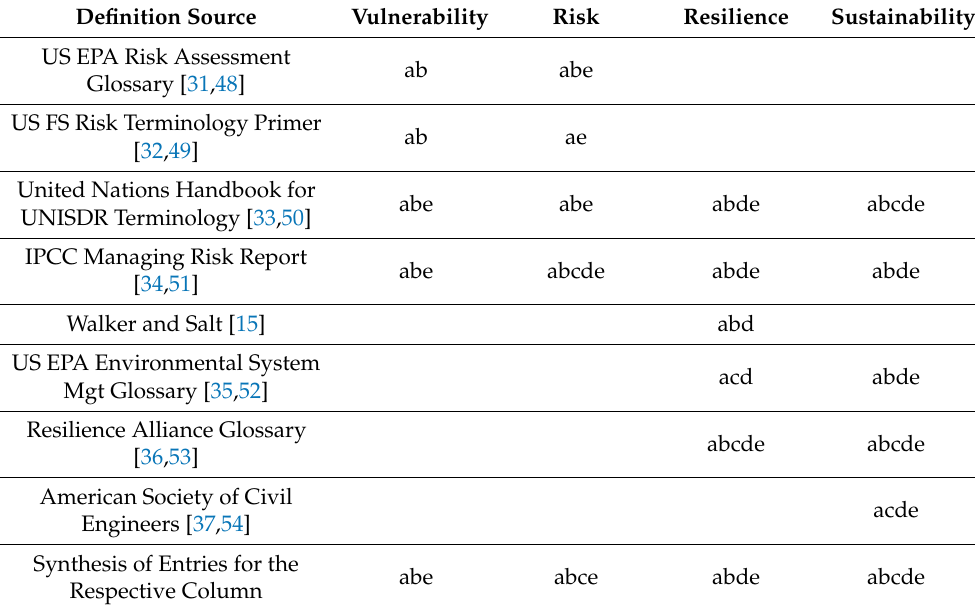
1 Table entry codes: a: system elements (e.g., stressor or receptor), each element characterized in terms of some level of functional performance. b: functional performance exposure relationship between elements. c: dose– response threshold(s) related to harm or functional performance. d: management action to address functional performance of that relationship. e: functional performance outcome from the